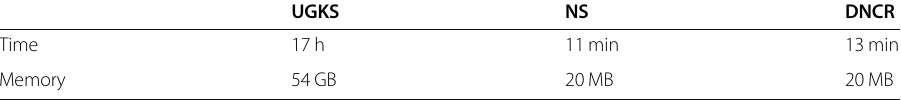
Table 4 CPU time and memory consumption UGKS NS DNCR Time 17